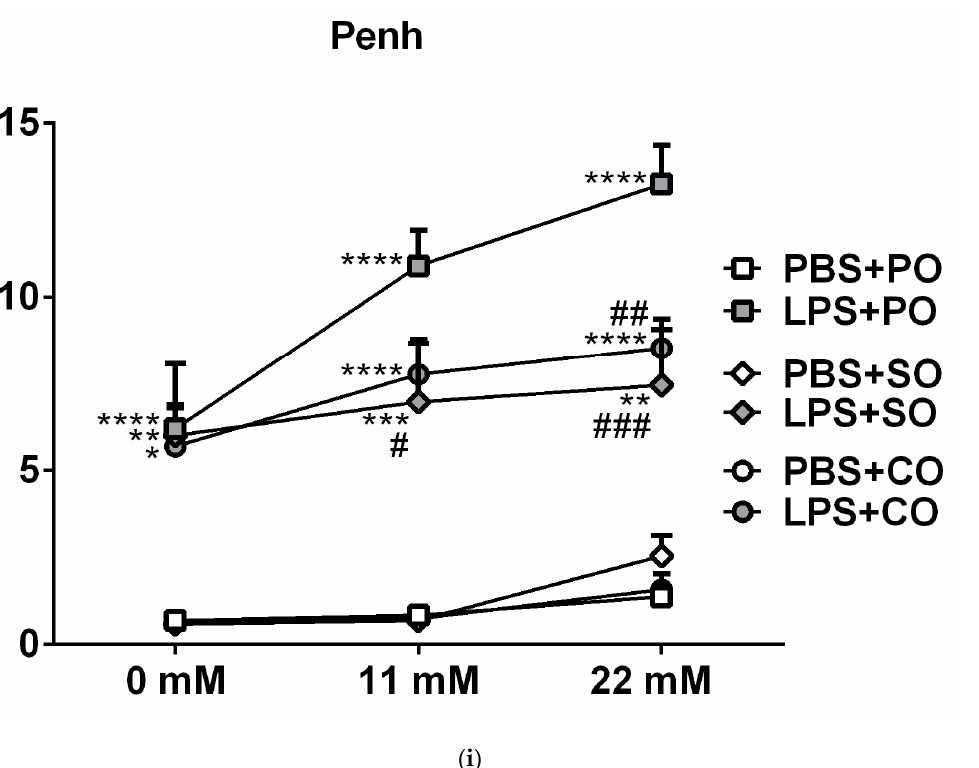
Figure 1. Effects of Scots pine (SO) and clove (CO) essential oils on ( a ) breathing frequency, ( b ) tidal volume, ( c ) minute ventilation, ( d ) relaxation time, ( e ) time of inspiration, ( f ) time of expiration, ( g ) peak inspiratory flow, ( h ) peak expiratory flow and ( i ) Penh compared to the negative control paraffin oil (PO), after lipopolysaccharide (LPS-black columns)/phosphate-buffered saline (PBS-white columns) treatment ( n = 6–8/group, * p < 0.05, ** p < 0.005, *** p < 0.0005, **** p < 0.0001 vs. respective PBS-treated group, # p < 0.05, ## p < 0.005, ### p < 0.0005 vs. LPS-PO-treated mice; two-way ANOVA followed by Tukey post-test).